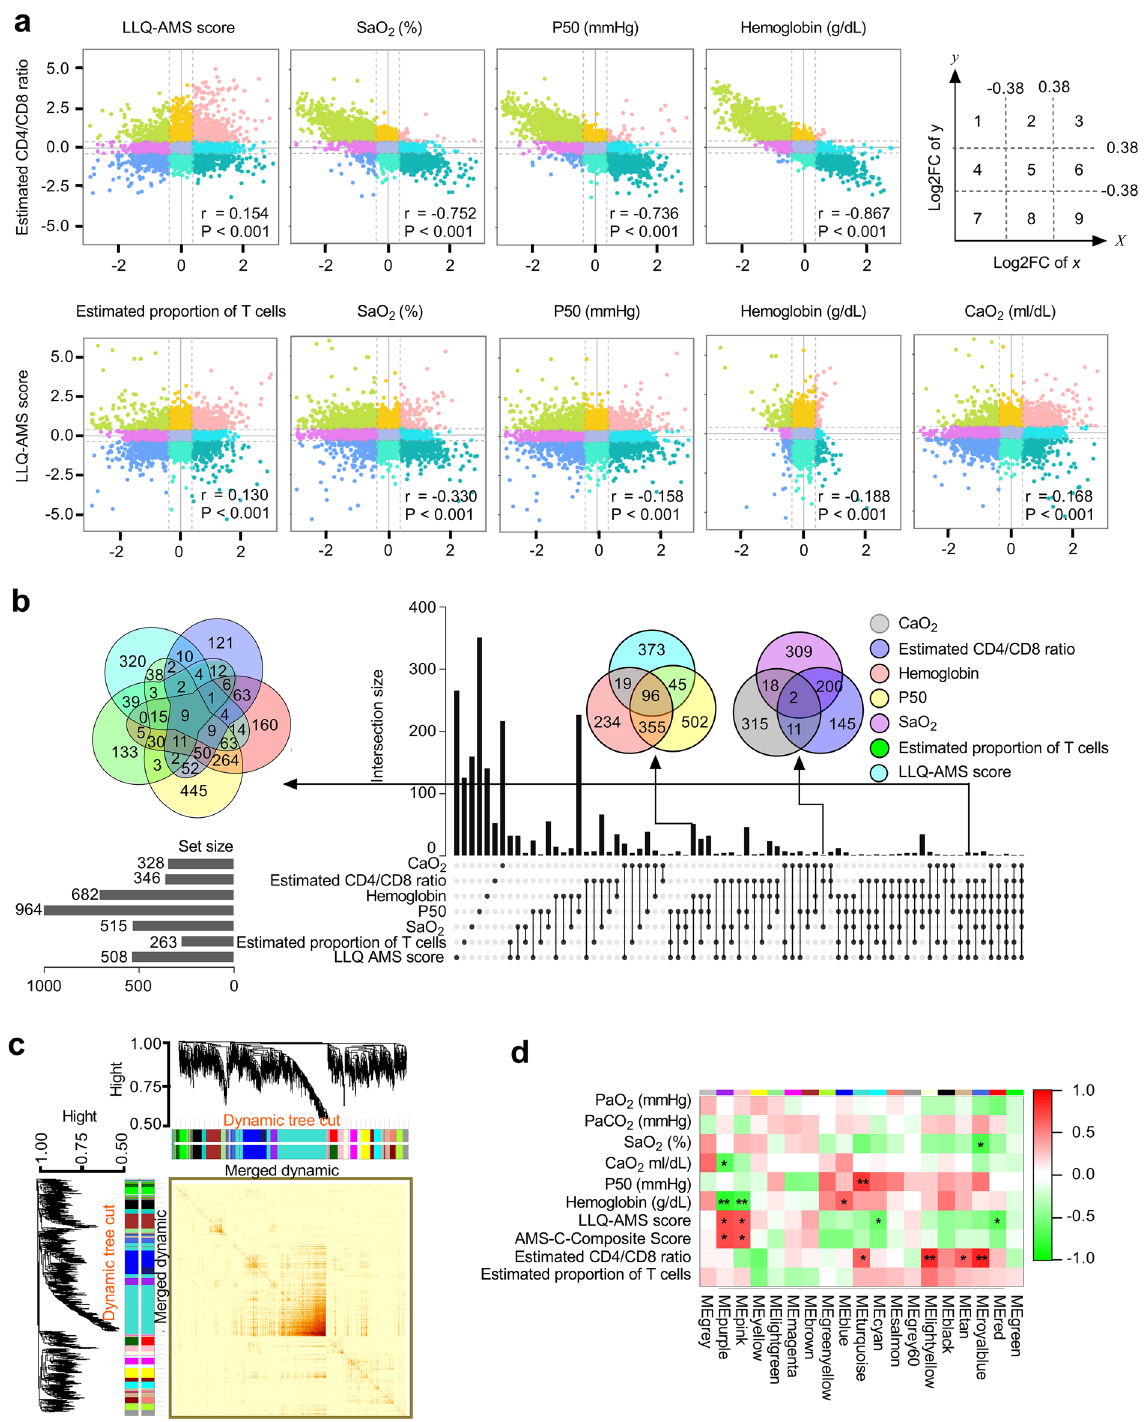
Figure 4. The gene signature underlying the phenotypes of sAMS. ( a ) Nine-quadrant diagram of the expression patterns of DGs across subgroups. The expression pattern was indicated with the log2 normalized FC. All DGs with log2FC > 0.38 or < -0.38 were visualized. Quadrant 1, DGs upregulated in classifier y but downregulated in x; quadrant 9, upregulated in x but downregulated in y; quadrant 3, upregulated in both x and y; quadrant 7, downregulated in both x and y. No significant correlations were observed in quadrants 2, 4, 5, 6 and 8. A total of 2286 DGs with log2FC > 1.3 or < -1.3 were selected for further analysis. ( b ) Venn analysis. The 2–6 intersections of DGs are indicated in the UpSet Venn diagram. The intersection size was displayed using upset bars and 3-way or 6-way Venn diagrams. ( c ) Network heatplot of the selected genes; ( d ) Module-trait relationships (Pearson correlation test, * P < 0.05, ** P <